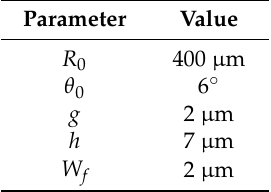
Table 1. Dimensions of the electrodes for the electrodynamic actuators of the microgripper .